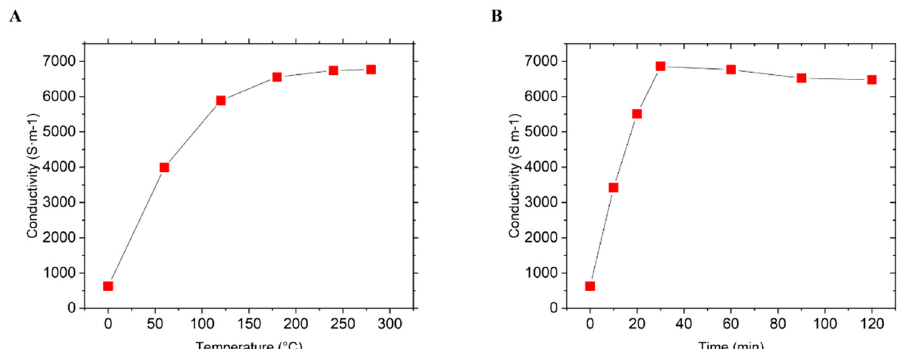
Figure 3. Conductivity measurements of printed graphene prints after treatment. ( A ) Conductivity changes dependent on the temperature, checked every 30 min. ( B ) Conductivity changes dependent on time at the same temperature of 280 °C.